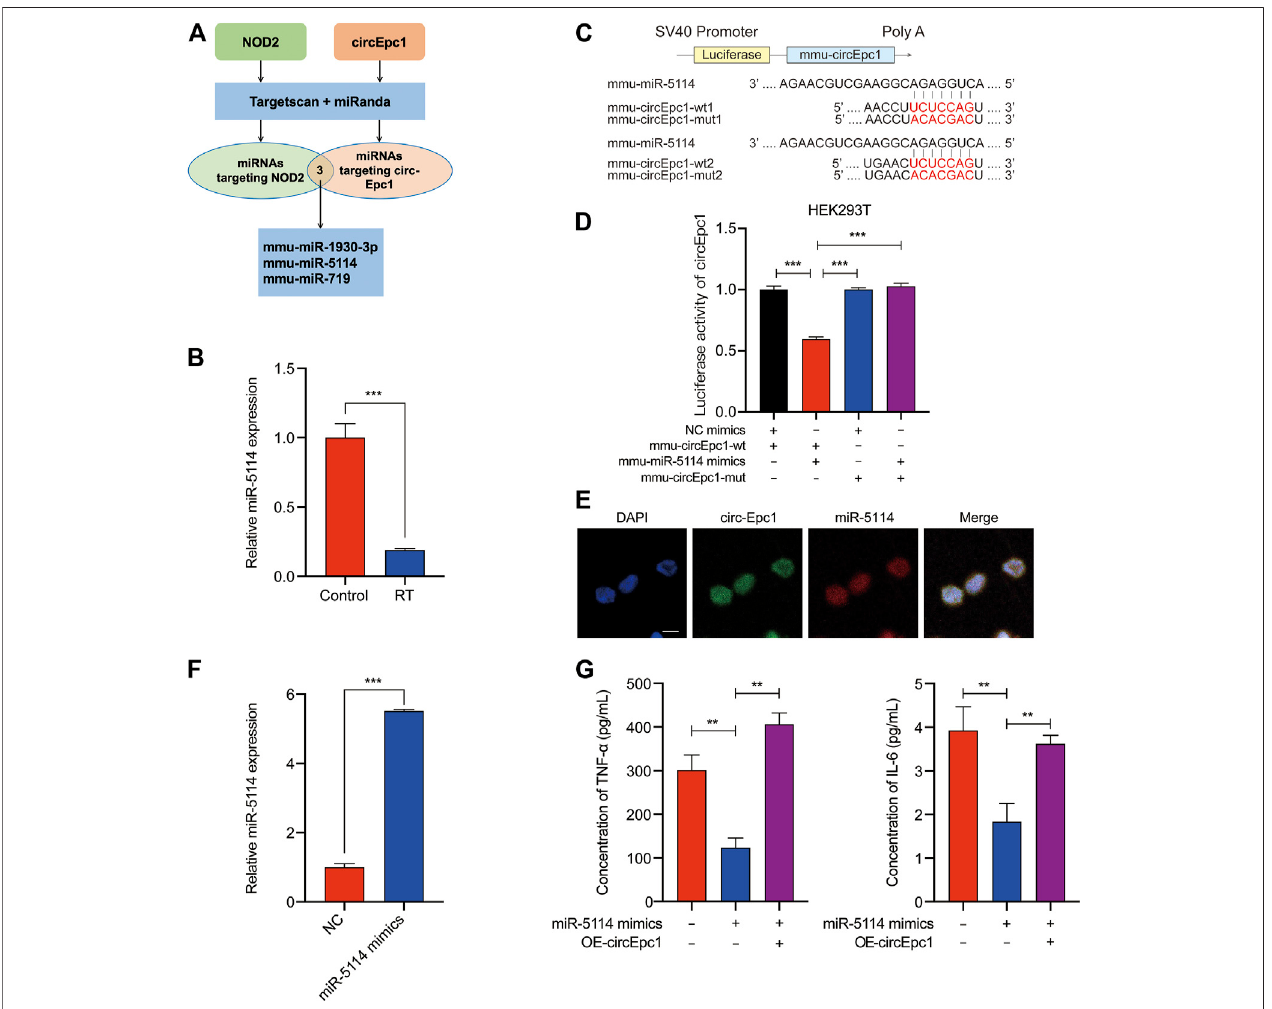
FIGURE 4 | CircEpc1 serves as a miRNA sponge of miR-5114. ( A) The schematic fl owchart shows the pipelines of miRNAs which could bond to circEpc1 and NOD2 3 ′ -UTR via online bioinformatic network. ( B) Expression level of miR-5114 in control and RT-treated RAW264.7 cells. ( C, D) Dual-luciferase reporter activity of circEpc1inHEK-293T cellsco-transfectedwithmiR-5114mimicsormimics NC.( E) MiR-5114 co-localizedwithcircEpc1 inthecytoplasmbyFISHanalysis,scalebar (cid:1) 100 μ m (F) Expression level of miR-5114 in RAW264.7 cells after transduction with miR-5114 mimics lentivirus. (G) TNF-a and IL-6 secretion in RT-treated RAW264.7 cells transfected with miR-5114 mimics alone or co-transfected with circEpc1. Data represent the mean ± SD from three representative experiments (* p < 0.05, ** p < 0.01, *** p < 0.001).